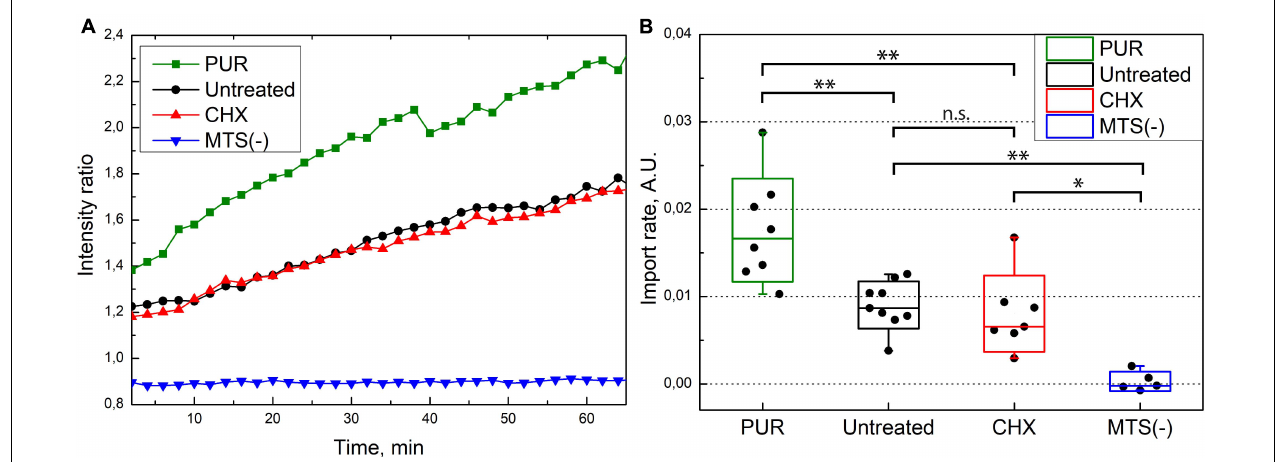
FIGURE 5 | (A) MTS-SNAP-tag protein import into the mitochondria. Each line represents the ratio of average mitochondria fluorescence to cellular fluorescence over time averaged for 6–9 cells under similar conditions. The PUR treated cells (green) show a higher import speed compared to the CHX- and untreated cells (red and black, respectively). The SNAP-tag protein (blue) shows no import into the mitochondria. (B) Import rate under different conditions. The ratio of average fluorescence from mitochondria and whole cell of the MTS-SNAP-tag protein over time is linearly fitted between 5 and 60 min, and the slope coefficients are plotted. The boxes show a standard deviation, the whiskers indicate the range of values. 7/7/9 cells from three separate experiments were used for puromycin/cycloheximide/no treatment, respectively. For the SNAP-tag protein experiment, five cells were used from a single experiment. The significance level is given according to the one-way ANOVA with the post hoc Tukey LSD test: ∗∗ p < 0.005, ∗ p < 0.05, n.s.–not